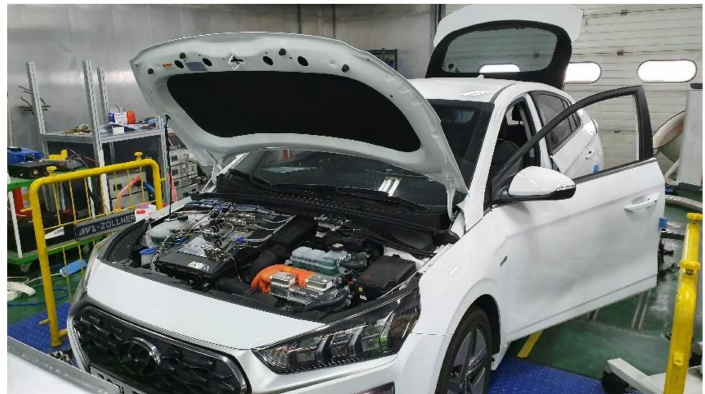
Figure 3. Dynamometer Test of Ioniq HEV.